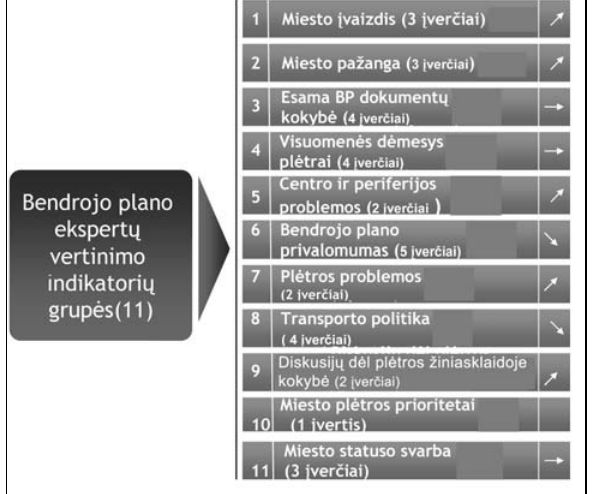
Fig 12 . Groups of indicators, assessments and trends of general plan experts’